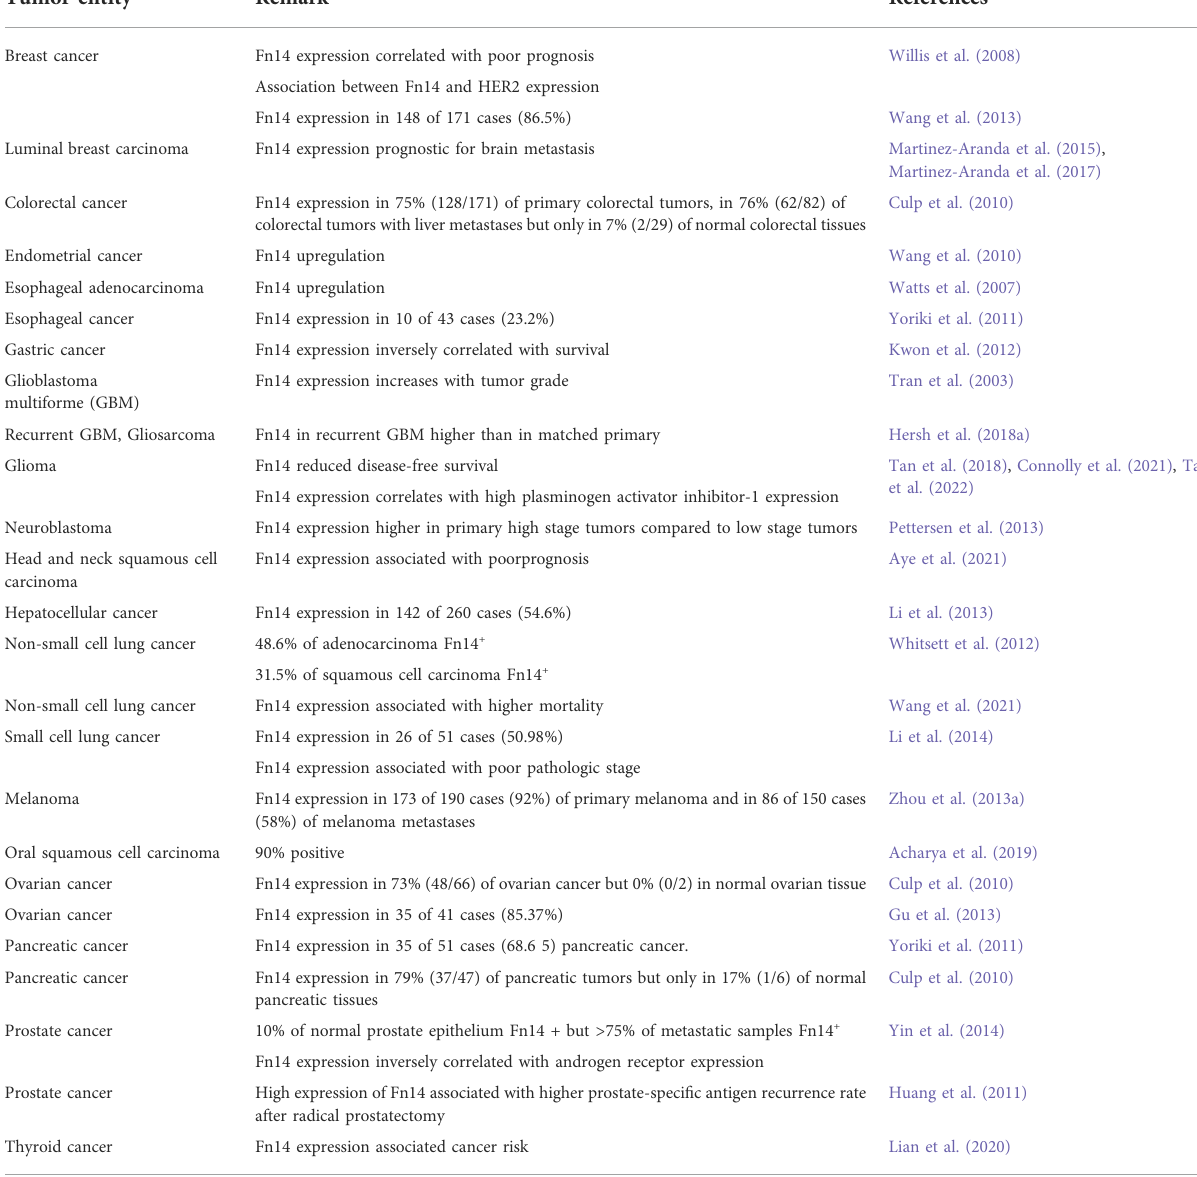
TABLE 1 Cancer-associated expression of